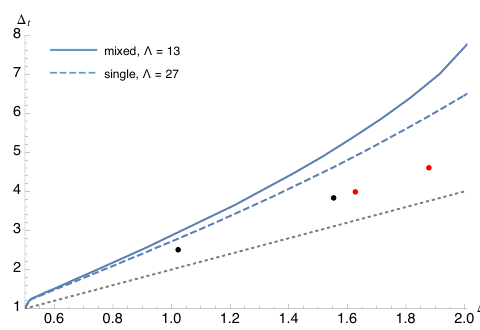
Figure 6 . Bound on the dimension of the first charge-2 parity-even scalar operator as a function of ∆ φ . The bound displays a kink in corresponding to the O (2) model. The continuous line was obtained using the mixed system of bootstrap equations at Λ = 13 ; the blue dashed line only uses the scalar correlator at Λ = 27 . The grey dotted line is the generalized free theory line. The red (black) dots correspond to the dimension of the monopoles with charge q = 1 / 2 and q = 1 in bosonic (fermionic) QED computed in large- N expansion [49, 50]. Here we show respectively N = 10 , 12 3 and N = 4 , 6